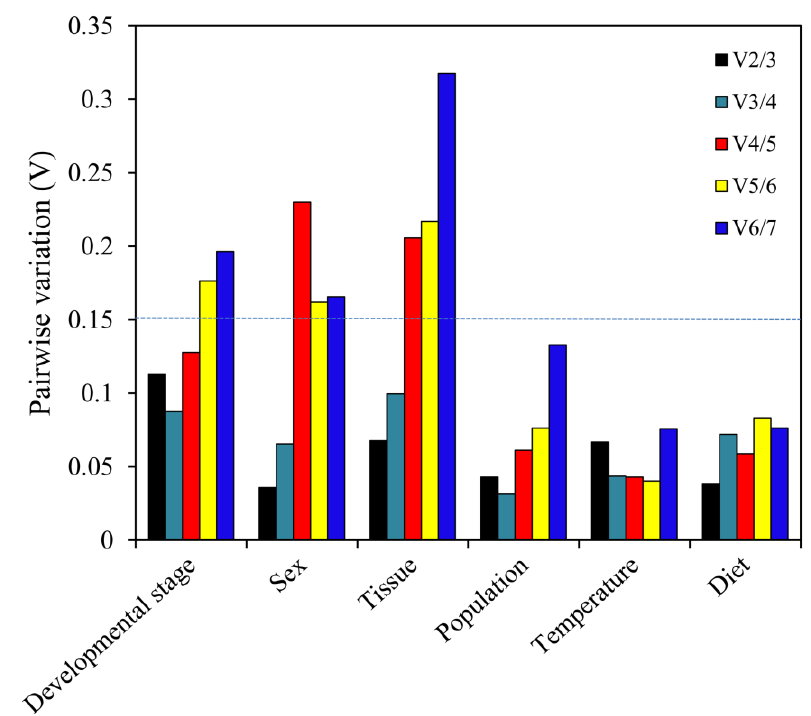
Figure 5. Pairwise variation (V) values using geNorm based on different comparisons: developmental stage, sex, tissue, population, temperature and diet.